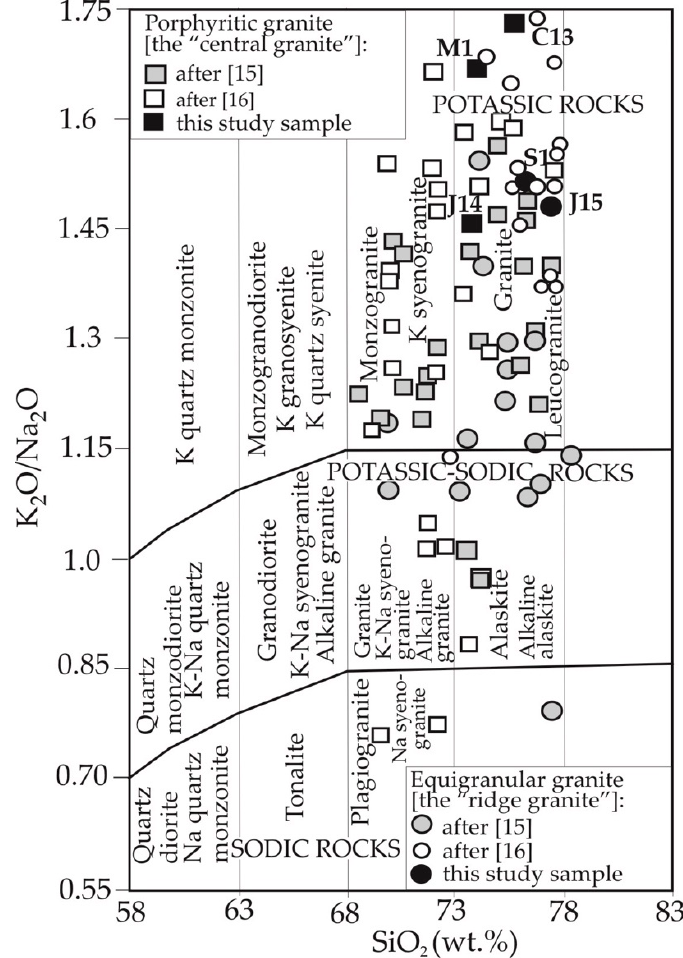
Figure 8. Classification of porphyritic (square) and equigranular (circle) granites from the Karkonosze Pluton on the diagram Na 2 O/K 2 O vs. SiO 2 ; Data after [16,17] and this study.